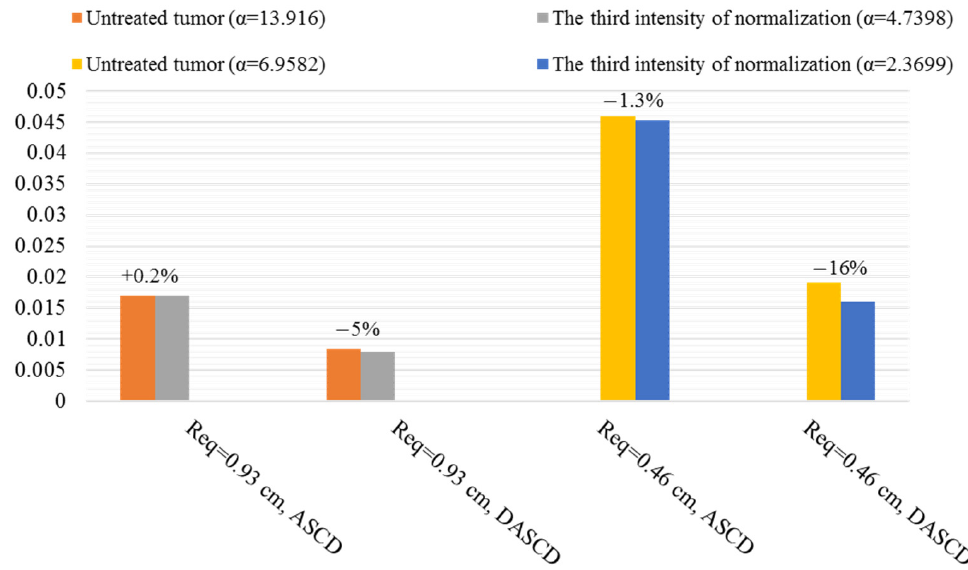
Figure 14. Summary of the positive influence of normalization on ASCD and DASCD of F ( ab (cid:48) ) 2 in different sizes. The percentage of change after applying the AAIN is seen above the bars.